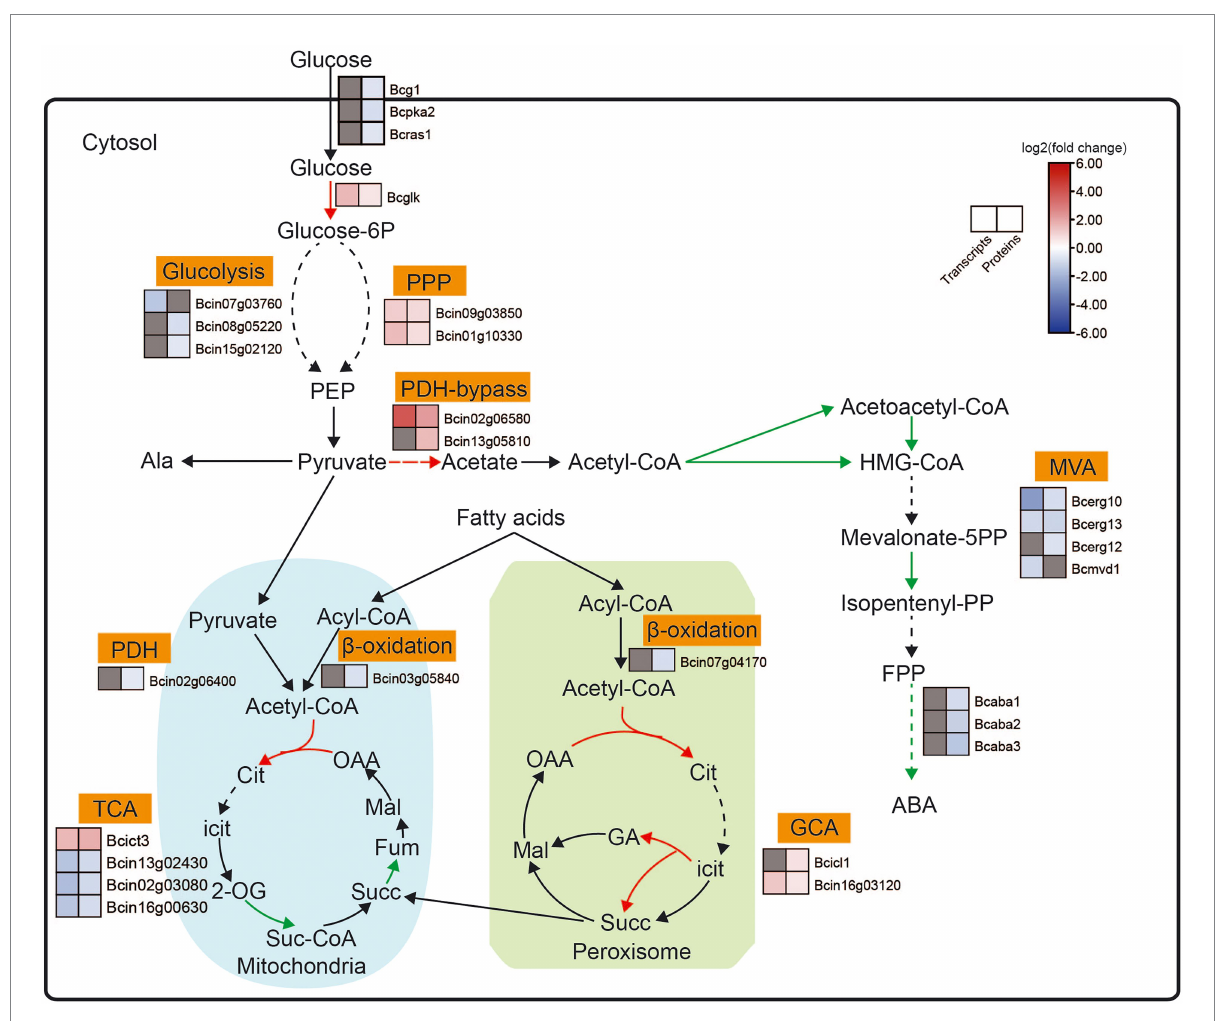
FIGURE 6 Expression pattern of key genes involved in ABA biosynthesis-related pathways between the B. cinerea TB-31 and Δ Bcfrp1. The heat map was generated with the software TBtools (Toolbox for Biologists) V1.0971. The gray color means no significant difference at the transcription or translation